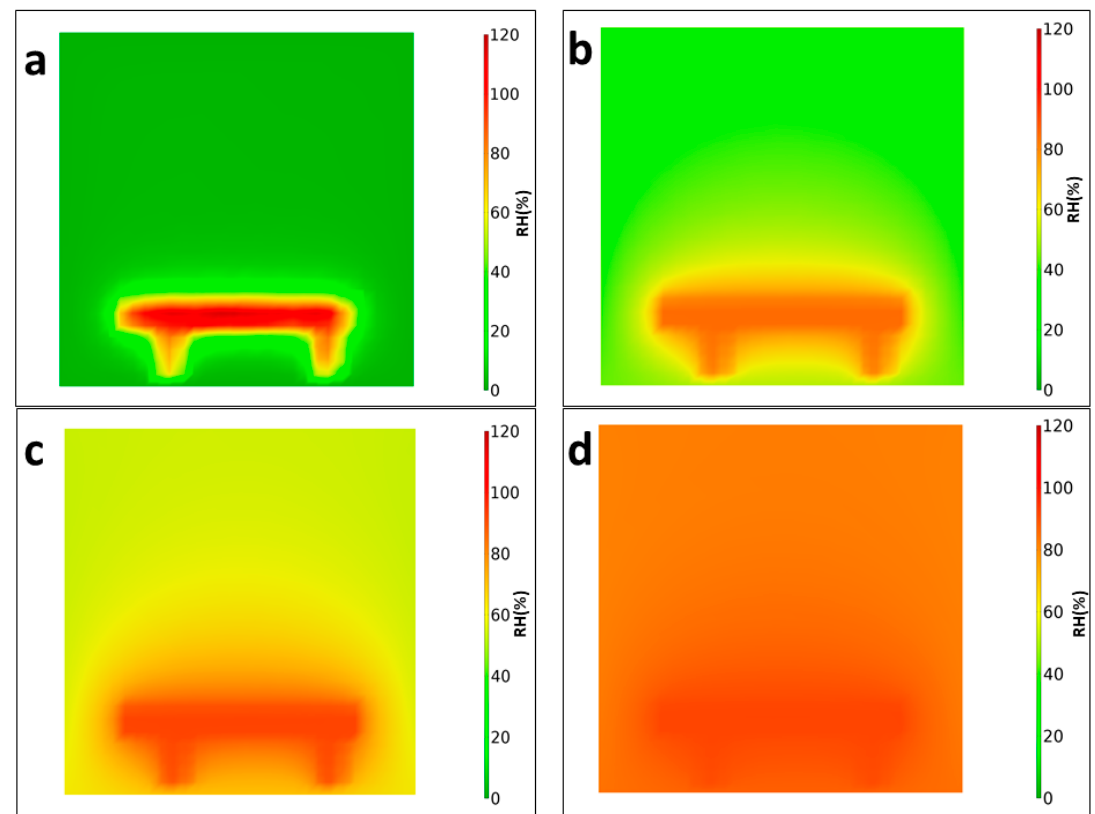
Figure 5. 2D cross-section of the computer simulation of the relative humidity evolution ( a ) shows over saturation as the frost starts to form at the working table at 0 min. ( b ) Relative humidity of air increases as the frost sublimate to liquid water droplets at 135 min. ( c ) At 200 min increase in air relative humidity as the water is released into the air. ( d ) The relative humidity inside the chamber is uniform by the end of the experiment at 400 min.